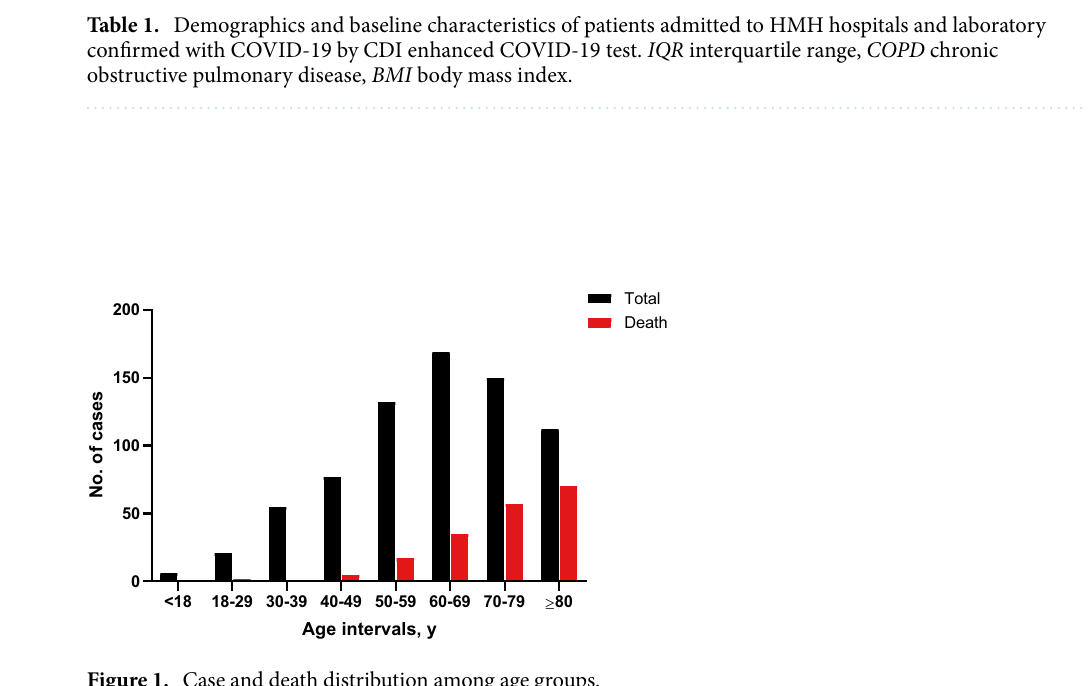
Figure 1. Case and death distribution among age